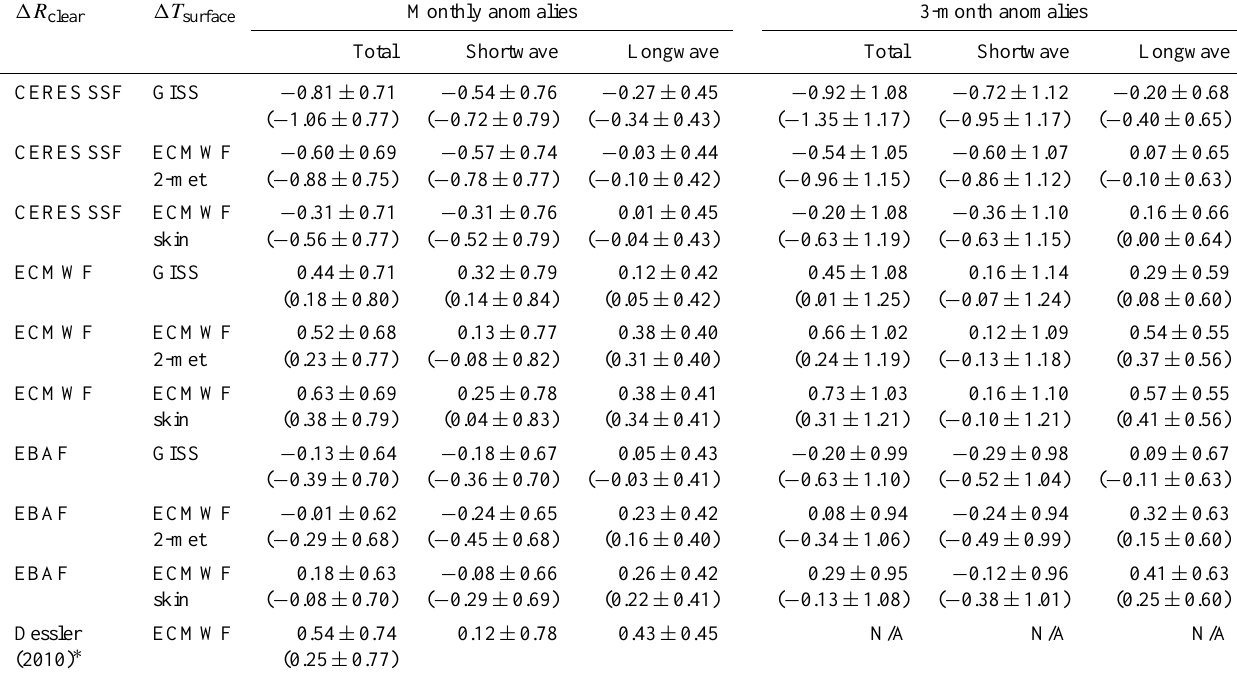
Table 1. The results of OLS regressions of 1R cloud against 1T surface , with 95% confidence interval over the March 2000 to June 2011 Terra period. Values in parentheses use the unadjusted values of 1 CRF in the regressions. All estimates are in Wm − 2 K − 1